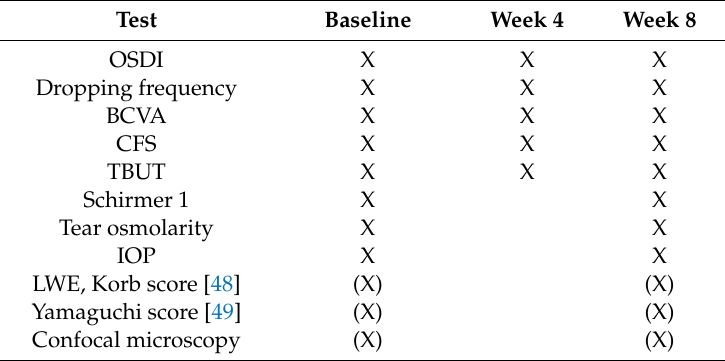
Table 1. Diagnostic testing schedule with optional tests in round brackets.